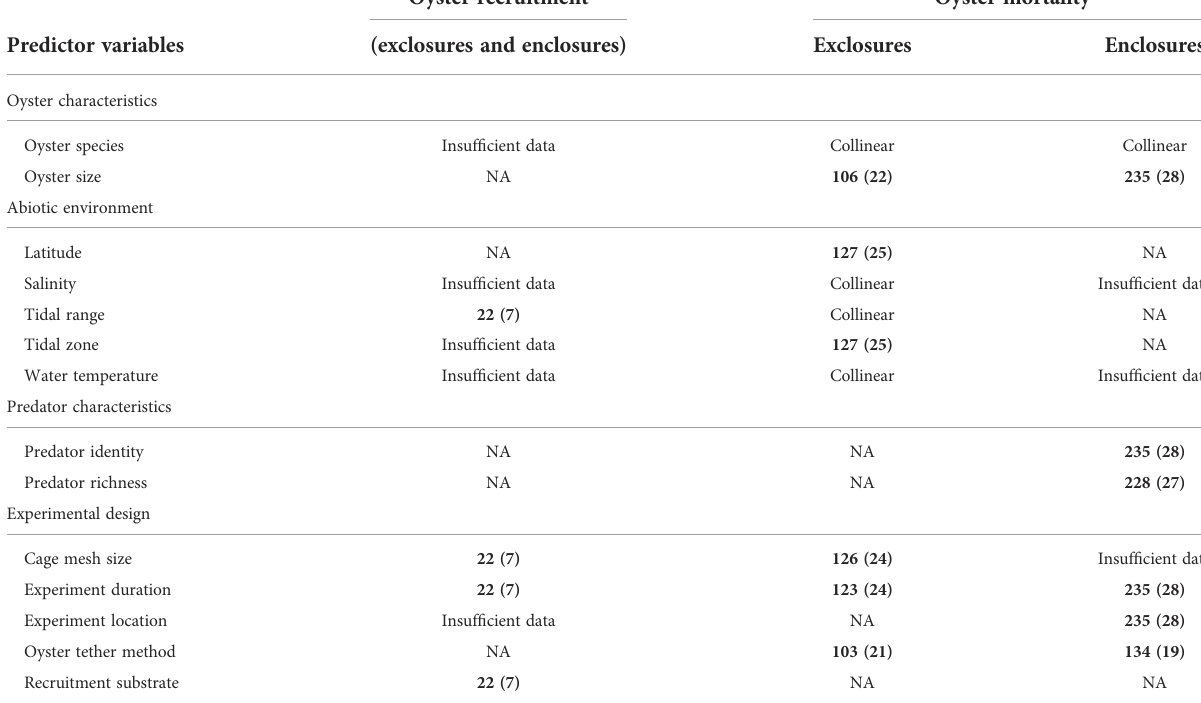
TABLE 1 Predictor variables collected for each of the 384 predation experiments organized by response variable (oyster recruitment or mortality) and, for oyster mortality, experiment type (exclosures or